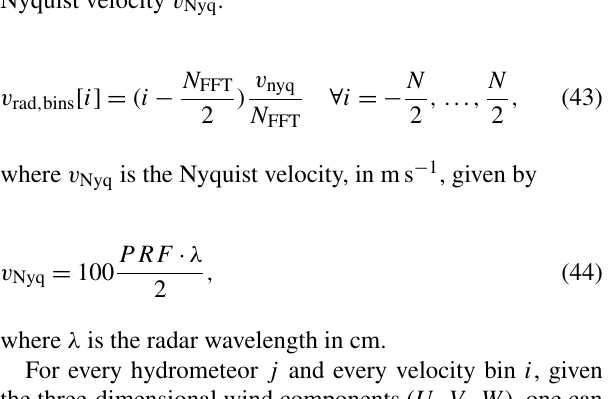
Figure 9. Trigononometric expression of the radial velocity as the power-weighted sum of the projection into the beam axis of the 3- dimensional wind field ( U,V,W ) and the hydrometeor terminal ve- locity v t .